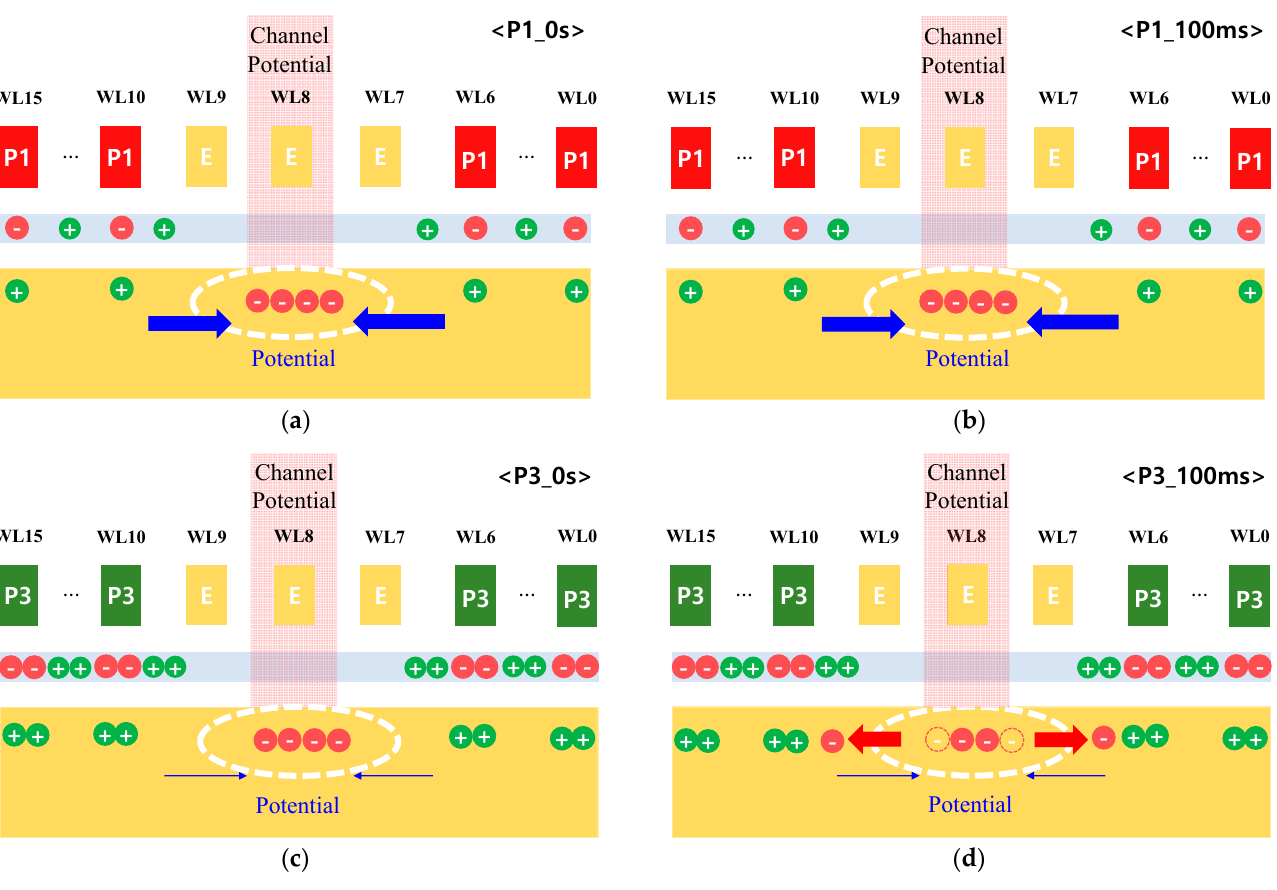
Figure 4. Schematic diagram of P1 at ( a ) 0 s and ( b ) 100 ms, and P3 at ( c ) 0 s and ( d ) 100 ms after NLSB occurred.